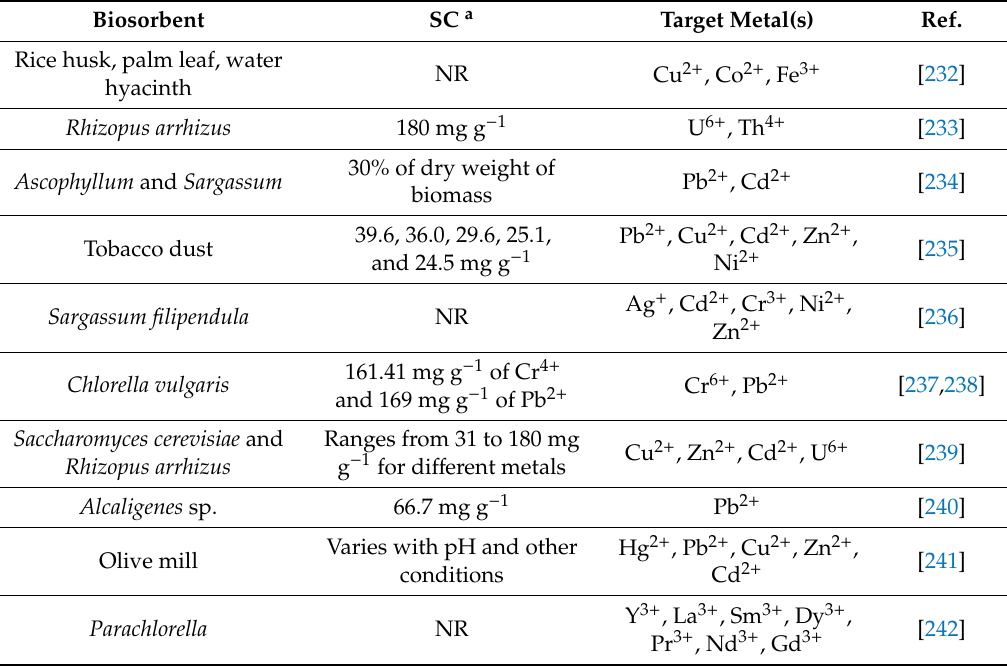
Table 9. Biosorbent materials for metal ion